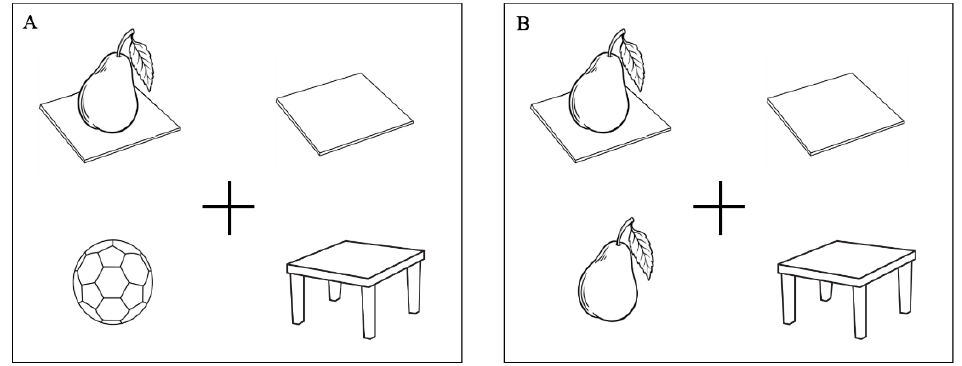
Figure 1. Examples of visual scenarios for the one-referent ( A ) and the two-referent ( B ) contexts modeled after [19] (Made by the authors).